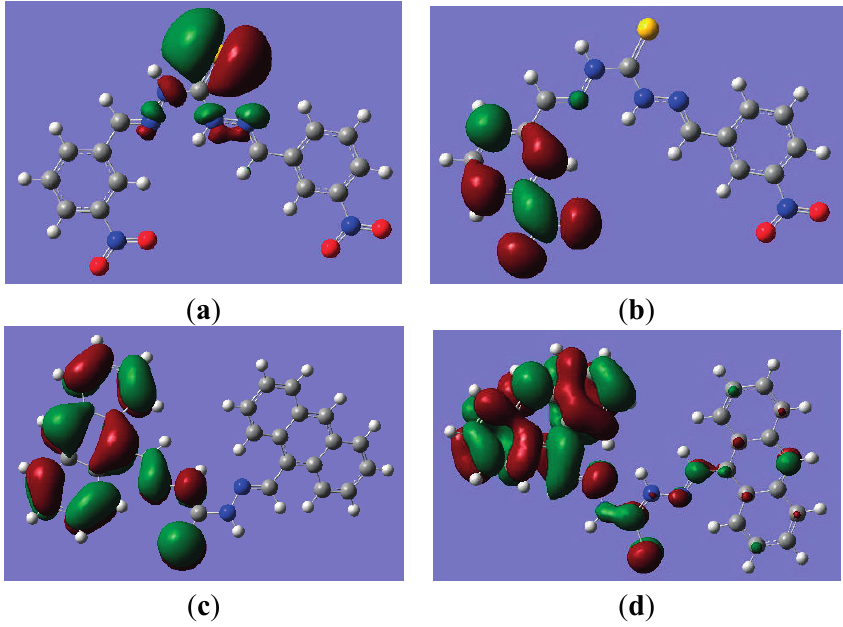
Figure 5. Molecular orbital level of compound 1 and 3 , ( a ) HOMO of 1 ; ( b ) LUMO of 1 ; ( c ) HOMO of 3 ; ( d ) LUMO of 3